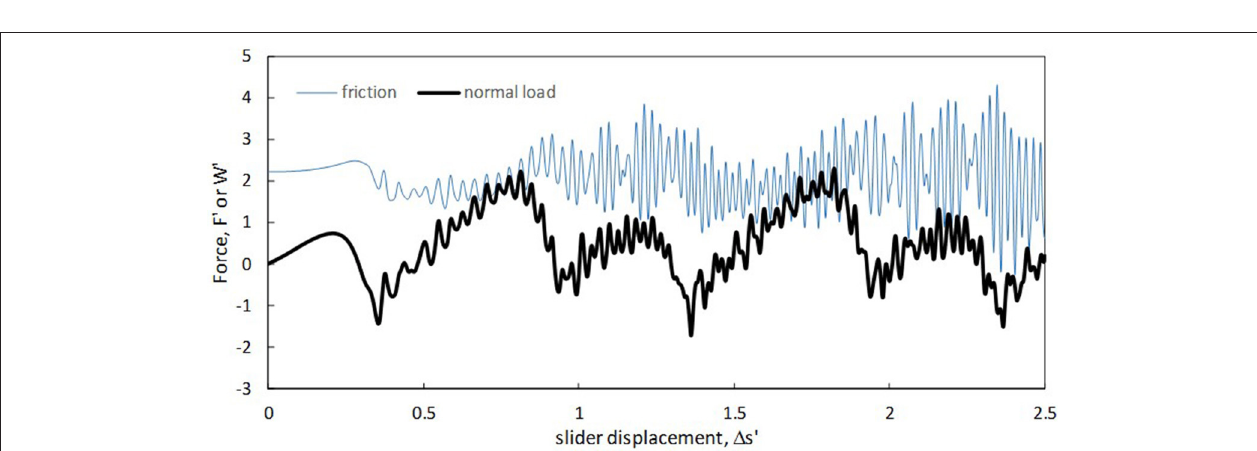
5 slider grid with a vertical surface separation of 0.7. ×